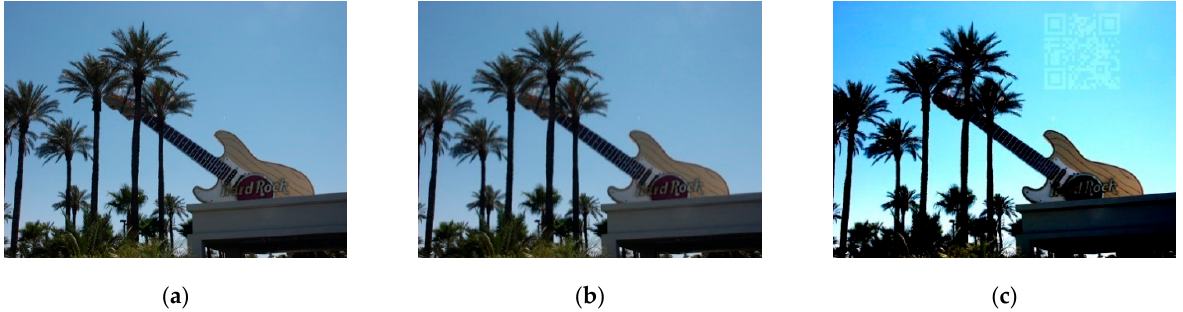
Figure 12. Sample set of images with QR code exhibited by the contrast and brightness combination, a = 2, b = − 50, ( a ) original image, ( b ) watermarked Image with PSNR = 51.63 dB, SSIM = 0.9992, NCD = 0.0096, ( c ) exhibited watermark.